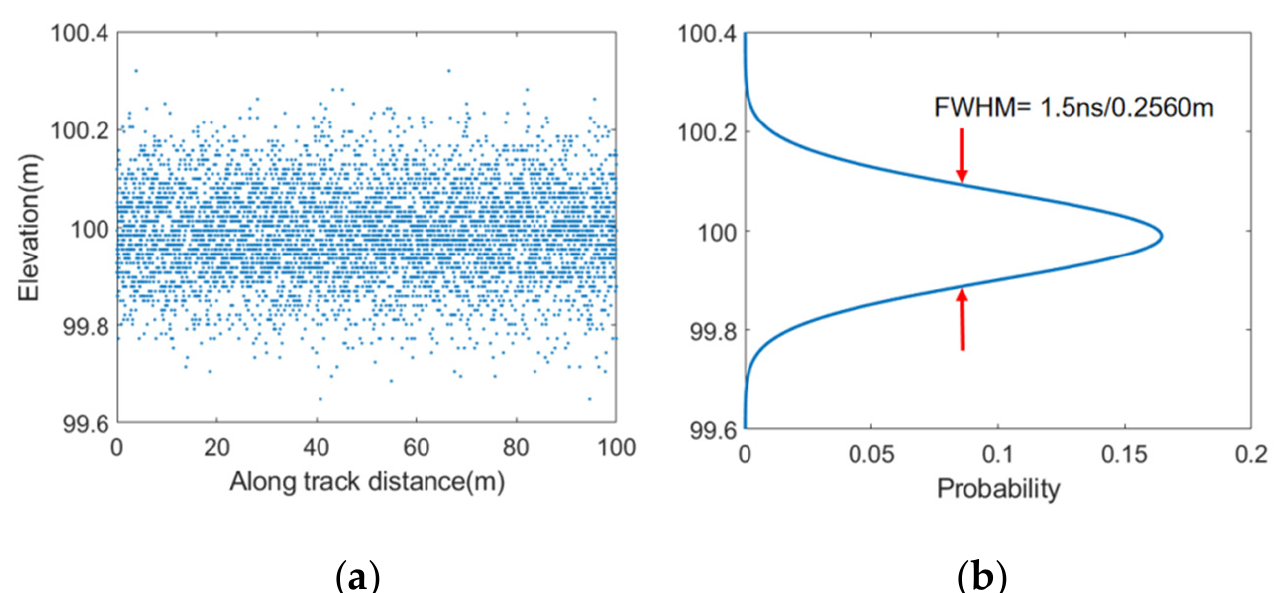
Figure 4. Signal simulation results without noise ( p = 0.55). ( a ) Two-dimensional scatter plot of signal simulation results. ( b ) When p = 0.55, the detection probability distribution of photons arriving at different altitudes, and its FWHM = 1.5 ns/0.2560 m.